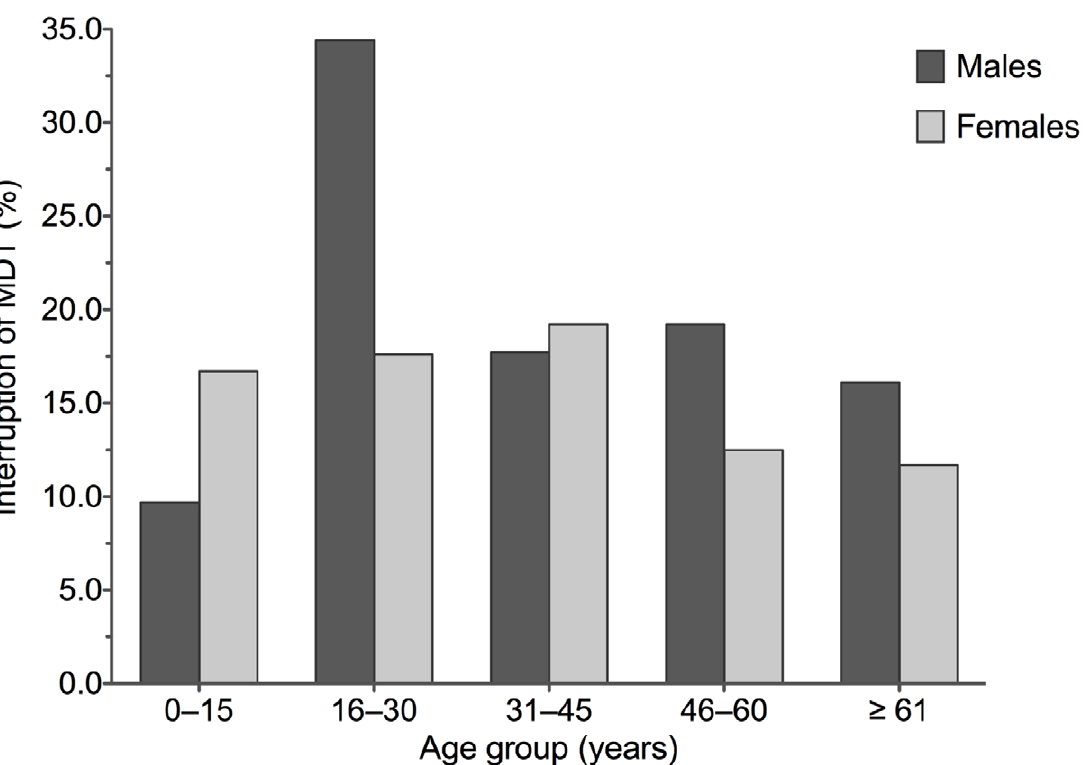
Figure 2. Relative frequency of interruption of MDT, stratified by gender and age group.